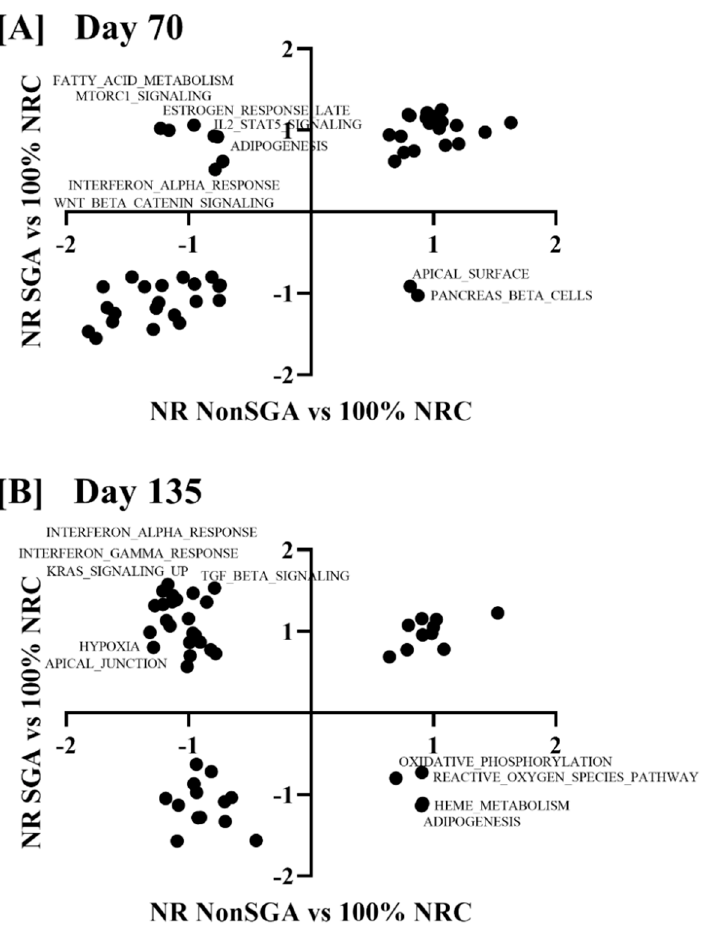
Figure 5. Gene set enrichment analysis of hallmark pathways in NR SGA compared to NR NonSGA placentomes at day 70 ( A ) and day 135 ( B ) of pregnancy. Nominal enrichment scores (NES) of NR NonSGA vs. 100% NRC analyses were plotted against NES values from NR SGA vs. 100% NRC analyses. Points in quadrants with (+, − ) or ( − , +) values were considered differentially regulated and were labeled with their pathway name.